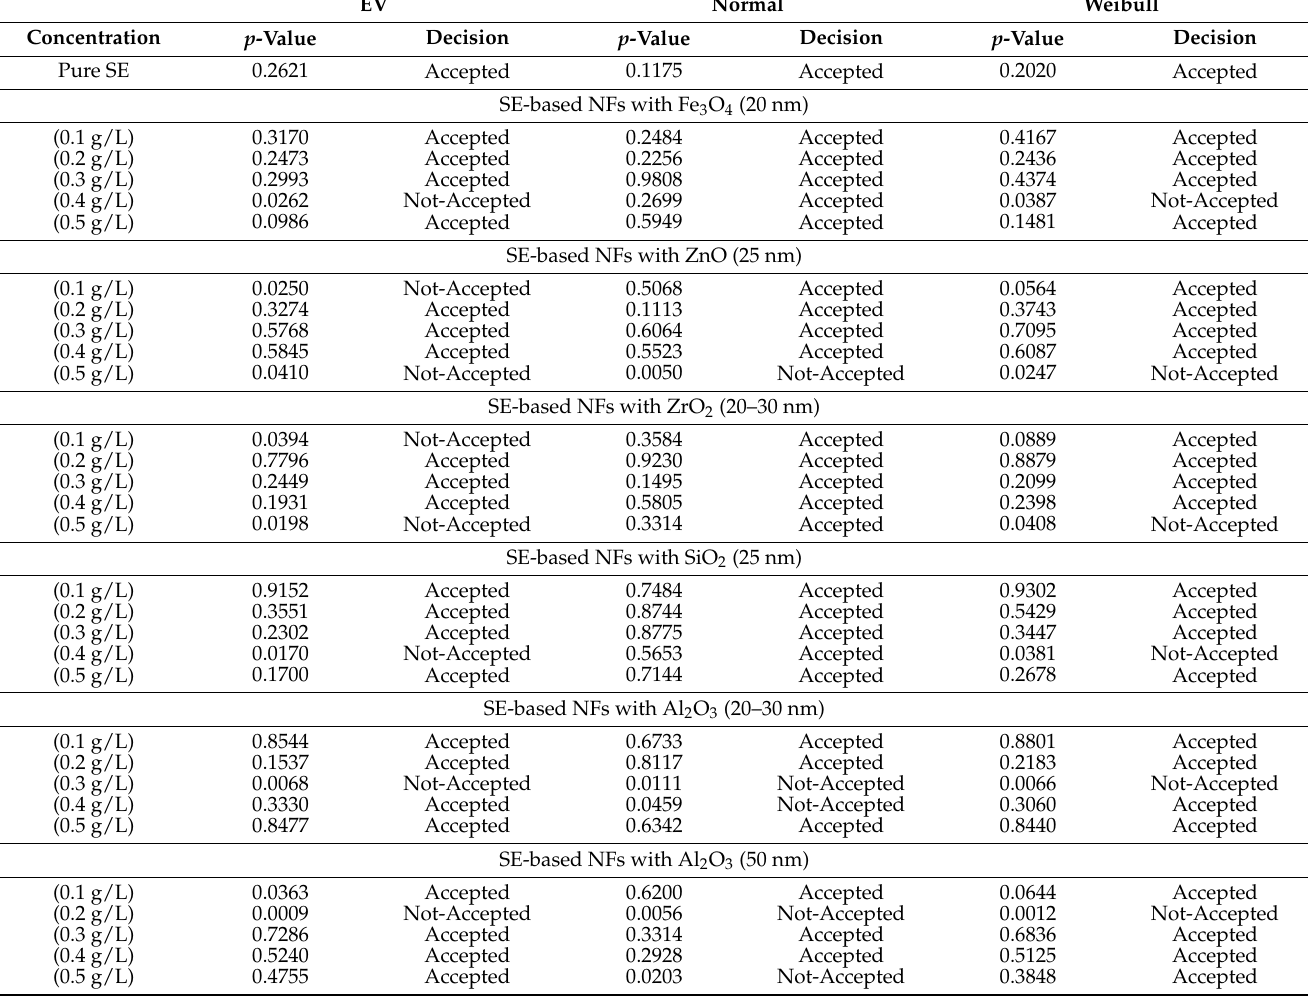
Table 4. Hypothesis test of conformity of breakdown voltage outcomes of various nanofluids to EV, normal, and Weibull distributions considering p -value calculation for the 2 mm electrode